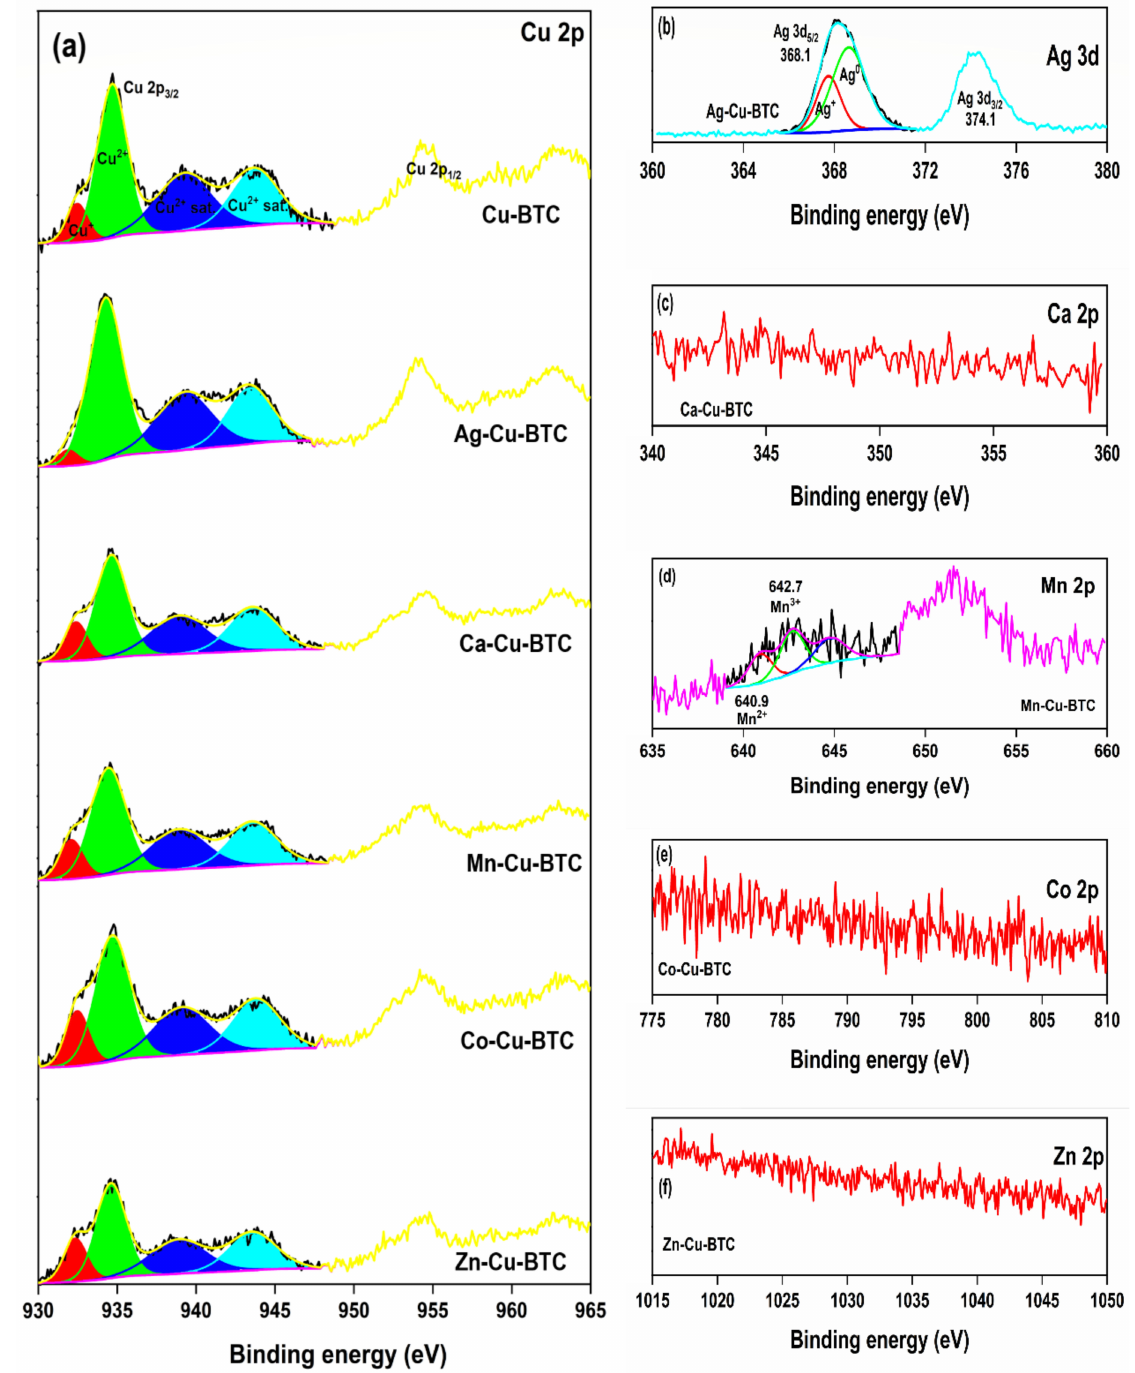
Figure 3. HRXPS ( a ) Cu 2p spectra of MOFs; ( b ) Ag 3d spectrum in Ag-Cu-BTC; ( c ) Ca 2p spectrum in Ca-Cu-BTC; ( d ) Mn 2p spectrum in Mn-Cu-BTC; ( e ) Co 2p spectrum in Co-Cu-BTC; ( f ) Zn 2p spectrum in